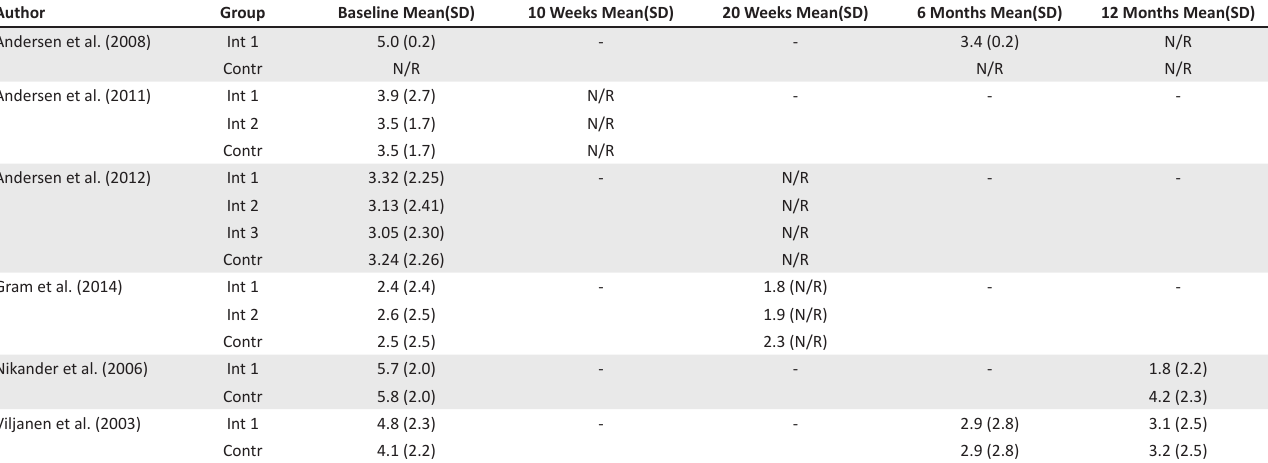
TABLE 5: The baseline and follow-up values for pain scores of studies incorporating strengthening exercise. Author